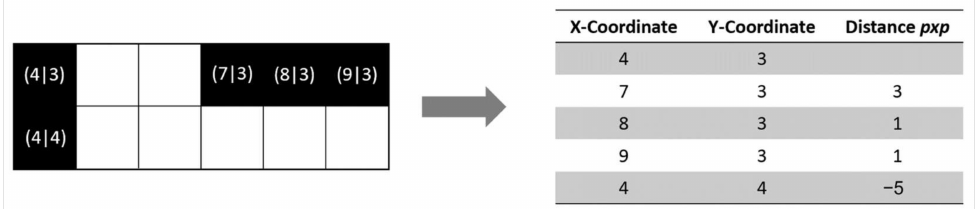
Figure 7. Example of extraction of drop coordinates and drop spacing depending on their